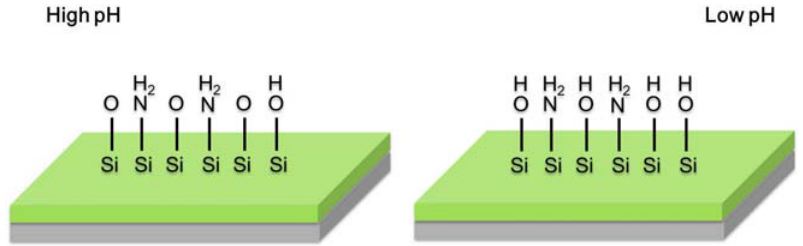
Figure 7. The formation state of silanol (Si-OH) and silamine (Si-NH high and low pH